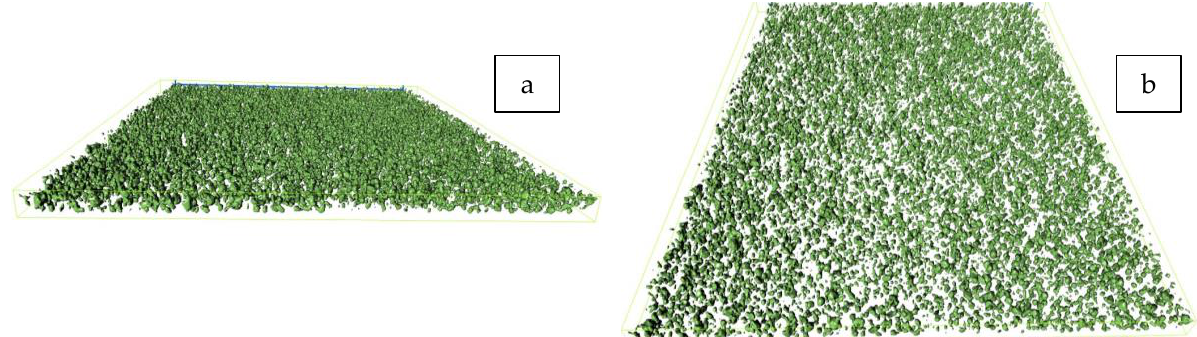
Figure 2. Micro-CT images ( a , b ), at two angles of view, of coatings prepared from the formula Zn – 80%-PC. The images represent projections of 3D tomographs of a specimen having a square upper surface with sides of 750 µm.